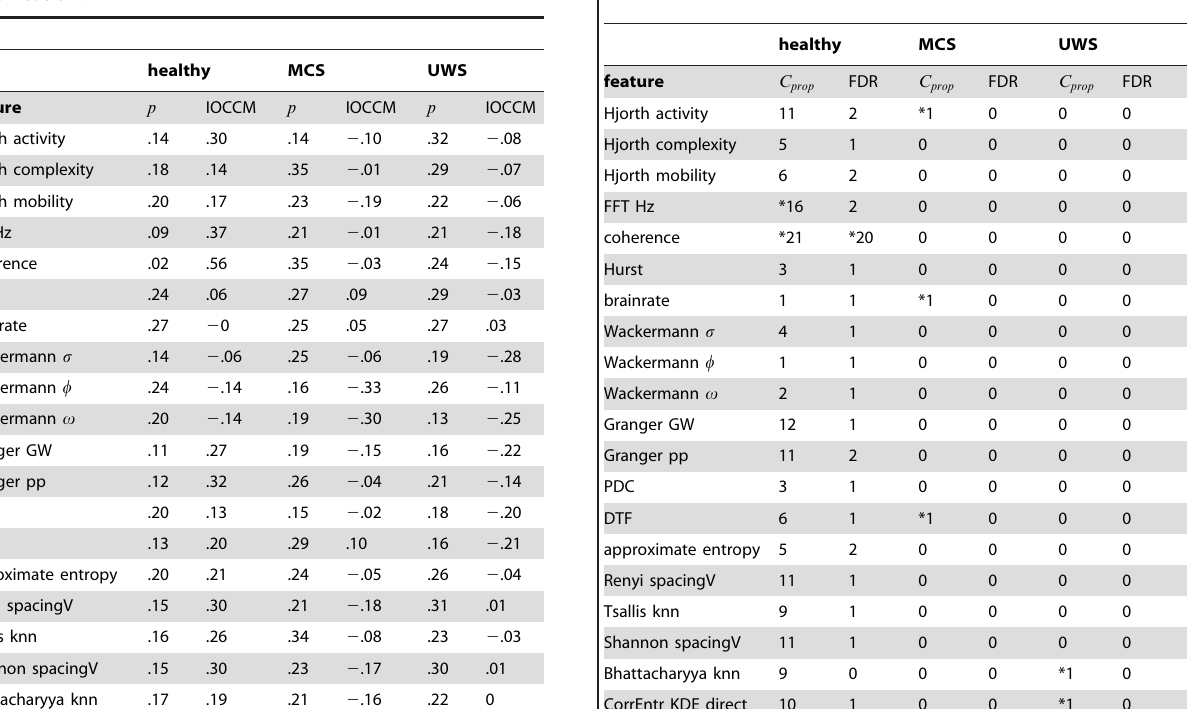
Table 3. Average p-values and effect sizes (IOCCM) for comparison of achieved accuracy to chance level in the SVM classification.